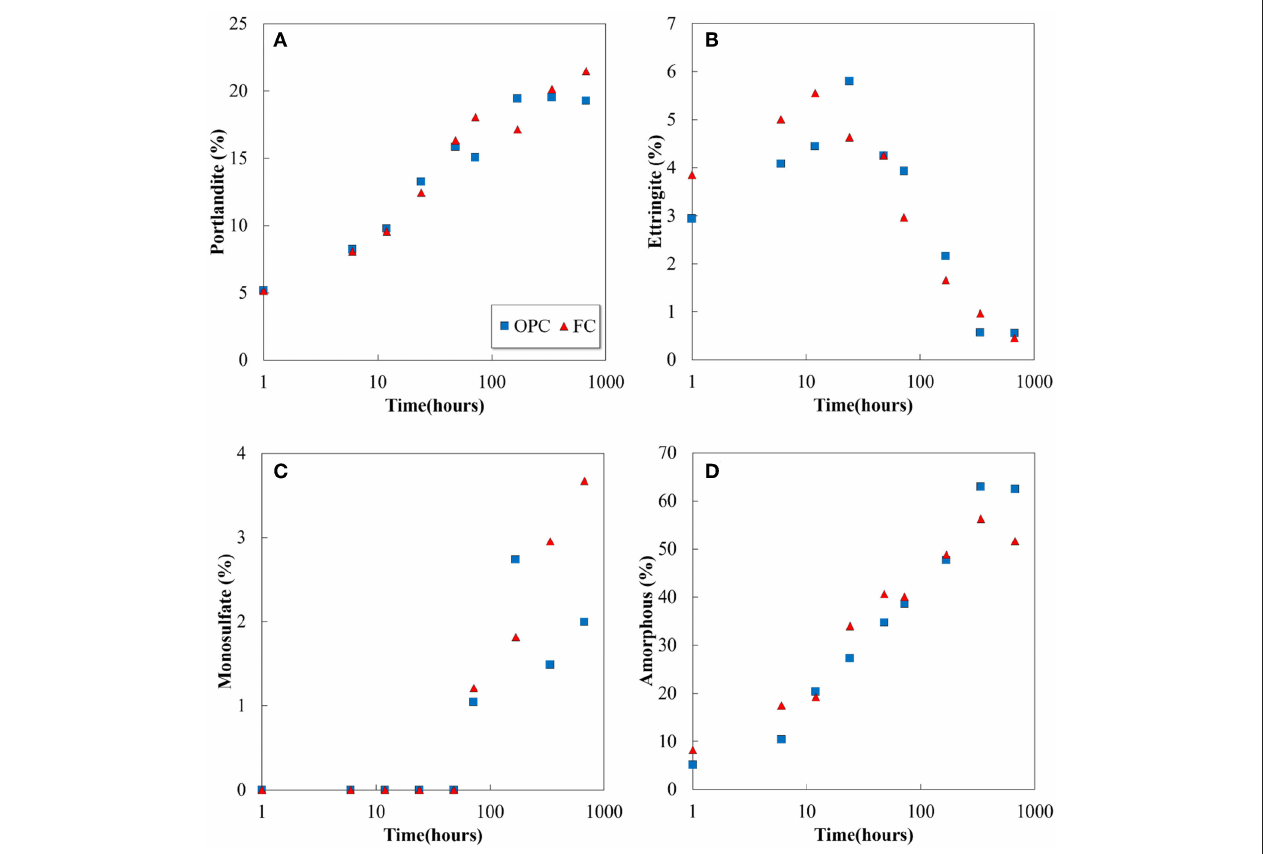
FIGURE 4 | Experimentally determined (A) portlandite, (B) ettringite, (C) monosulfate, and (D) amorphous contents variations as a function of hydration time for OPC and